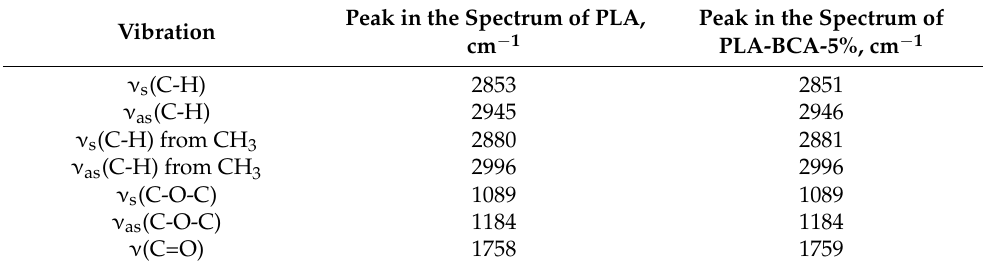
Table 4. Comparative values of the vibration frequencies in the FTIR spectra of PLA and PLA- BCA-5%.